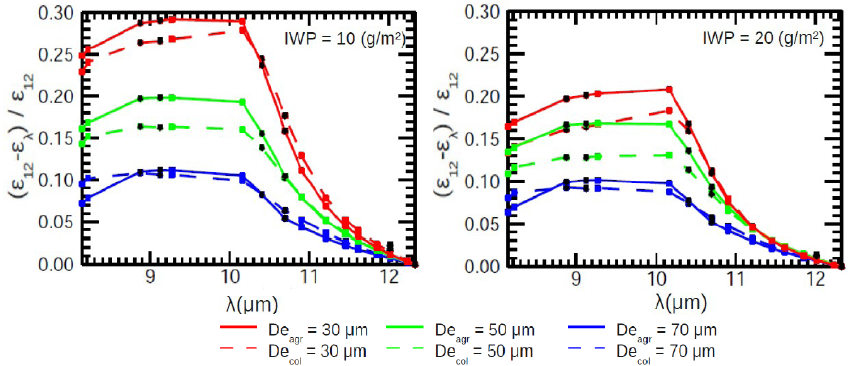
Fig. 3. Cirrus spectral emissivity difference, normalized by cirrus emissivity at 12µm, as a function of wavelength, separately simulated for aggregate-like and column-like ice crystal habit (full lines and broken lines, respectively). Results are shown for two values of IWP, 10gm − 2 (left) and 20gm − 2 (right) and for three values of D e (10, 30, 50µm, red, green and blue, respectively). The six AIRS channels selected for the retrieval are indicated as black squares.